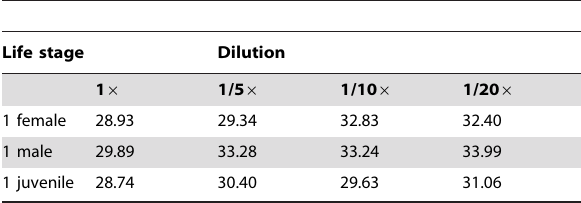
Table 3. Real-time PCR results for nematode sample no. 2013–33795 with different life stages and dilutions.